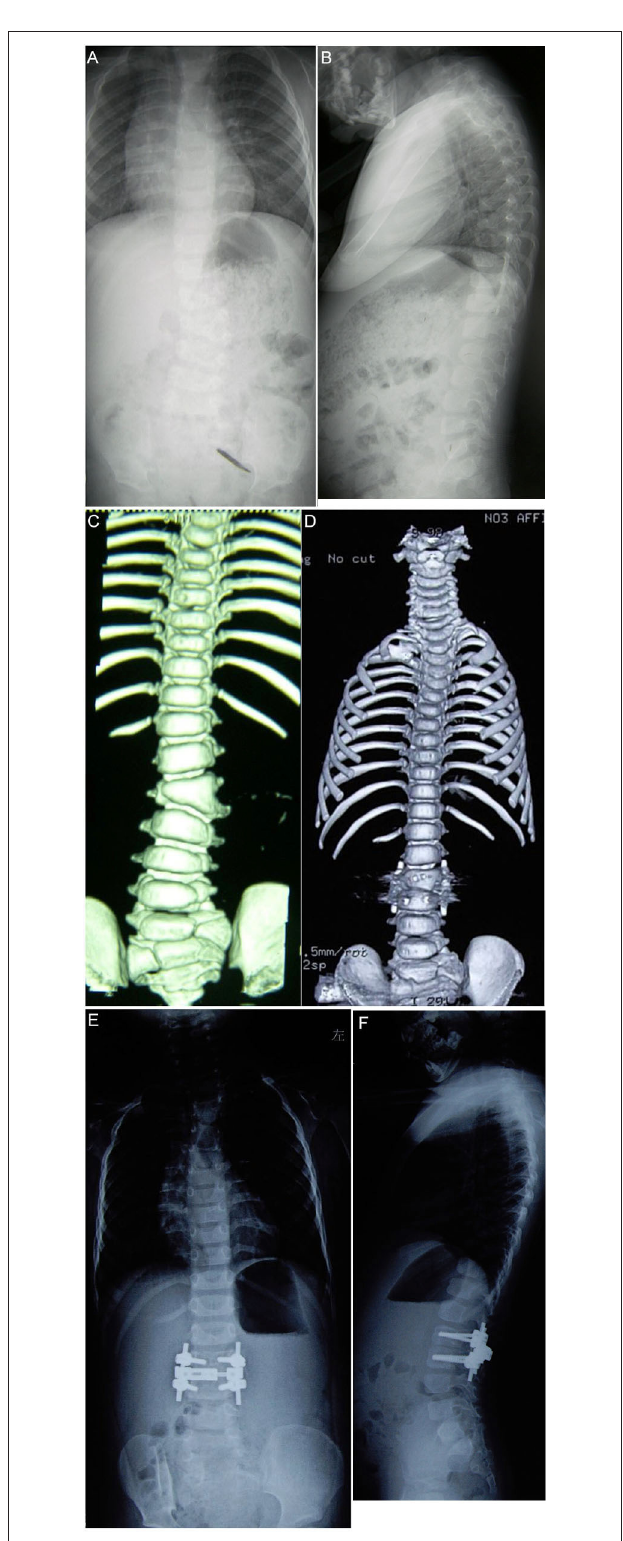
FIGURE 1 | The child is a 2-year-old boy. Preoperative x-ray [ (A) coronal position, (B) sagittal position]and computed tomography (CT) (C) reveal that local deformity left of the L3 hemivertebra is obvious, and hemivertebra